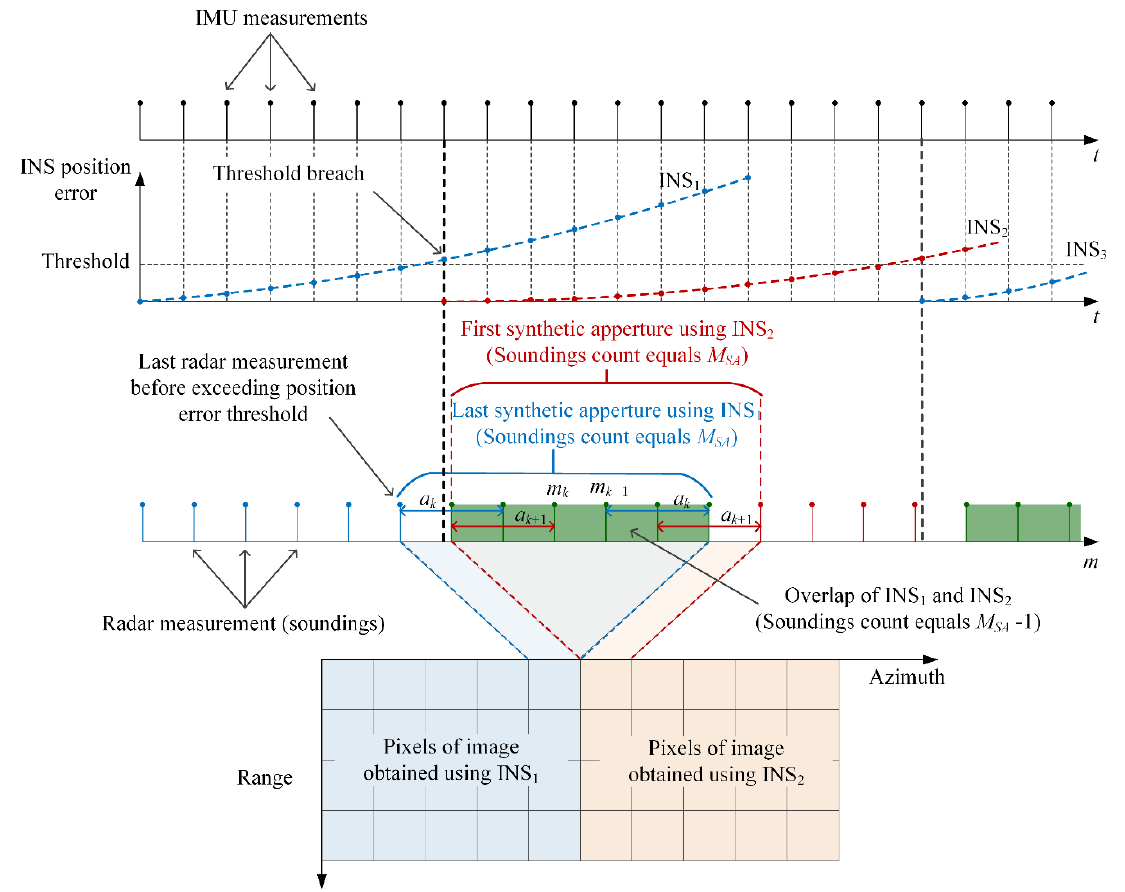
Figure 3. INS instances switching in